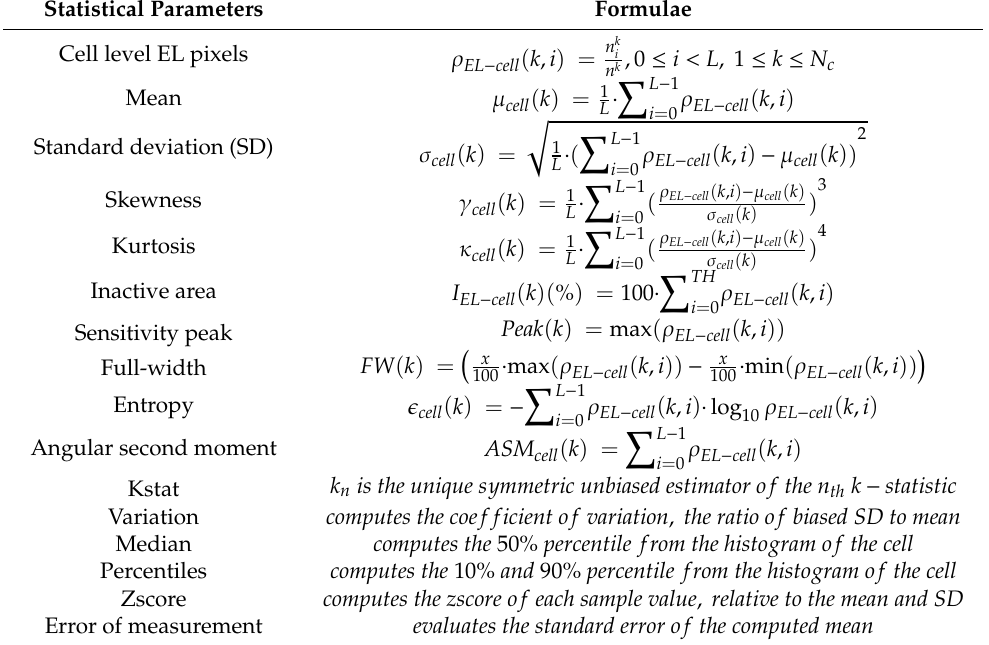
Table A1. Derived statistical parameters from the pixel intensity histogram of an EL cell image [49,50]. Statistical